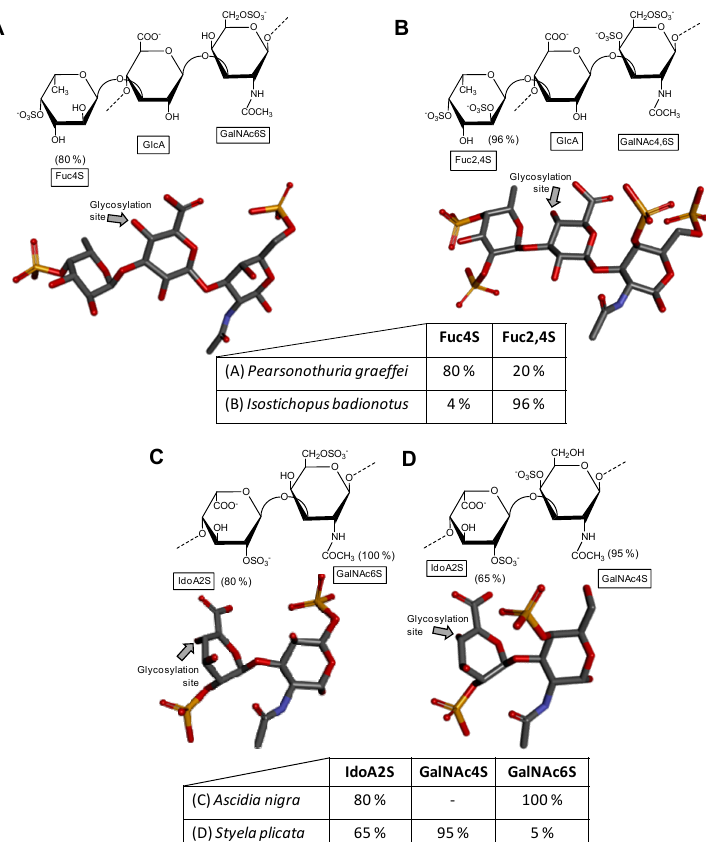
Figure 2. Haworth projections and stick model representations of the galactosaminoglycan structures from marine invertebrates. ( A , B ) Fucosylated chondroitin sulfates from two holothurian species: ( A ) Pearsonothuria graeffei mostly composed of {[Fuc4S- α (1 → 3)]-GlcA-( β 1 → 3)-GalNAc6S} whose GalNAc6S is β (1 → 4)-linked to the GlcA of the next unit to make up the backbone (disaccharide of backbone extracted from PDB ID 1OFM as model) [40], and ( B ) Isostichopus badionotus mostly composed of {[Fuc2,4S- α (1 → 3)]-GlcA-( β 1 → 3)-GalNAc4,6S} whose GalNAc4,6S is β (1 → 4)-linked to the GlcA of the next unit to make up the backbone (disaccharide extracted from PDB ID 1OFM as model) [40]. Dermatan sulfate from two ascidian species: ( C ) Ascidia nigra mostly composed of [IdoA2S-( α 1 → 3)-GalNAc6S] whose GalNAc6S is β (1 → 4)-linked to the IdoA2S of the next disaccharide unit (disaccharide extracted from PDB ID 1OFL as model) [42], and ( D ) Styela plicata mostly composed of [IdoA2S-( α 1 → 3)-GalNAc4S] whose GalNAc4S is β (1 → 4)-linked to the IdoA2S of the next disaccharide unit (disaccharide of backbone extracted from PDB ID 1OFL as model) [43]. The unsaturated uronic acid ( ∆ 4,5 UroA) of the original structures 1OFM and 1OFL were converted respectively to GlcA and IdoA. The monosaccharide nomenclatures are Fuc2,4S for 2,4-di-sulfated fucose; Fuc4S for 4-sulfated fucose; GlcA for glucuronic acid; GlcNAc for N -acetylglucosamine; GalNAc4S for 4-sulfated N -acetylgalactosamine, GalNAc6S for 6-sulfated N -acetylgalactosamine, GalNAc4,6S for 4,6-di-sulfated N -acetylgalactosamine and IdoA2S for 2-sulfated iduronic acid. The colors of the atoms used in the representations are grey for carbon, blue for nitrogen, red for oxygen and yellow for sulfur. The hydrogen atoms were omitted for visual simplification. The arrows labeled as “Glycosylation site” indicate the position of the glycosidic bond. Structures were created using ChemDraw Ultra 8.0 for Haworth projections and Discovery Studio Visualizer v.4.5 software (BIOVIA, Dassault Systèmes) for 3D representations. The monosaccharides are displayed in their commonest chair configurations: 4 C 1 for GlcA and GalNAc(6S, 4,6S or 4S) and 1 C 4 for IdoA2S and Fuc(4S and 2,4S). The percentage of sulfation patterns on the lateral Fuc residues of each holothurian fucosylated chondroitin sulfate and on the IdoA and GalNAc units of the ascidian dermatan sulfates are shown as inserts at the bottom of the panels and close to the respective units.